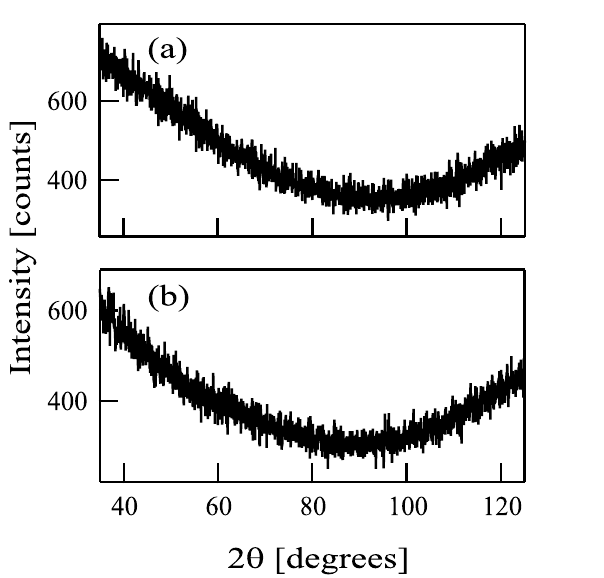
Fig 7. X-ray diffraction patterns of films deposited on Si substrates following the injection of (a) Ar + and (b) N + ions in conjunction with hexamethyldisilazane. Substrate temperature during the deposition experiments was 540